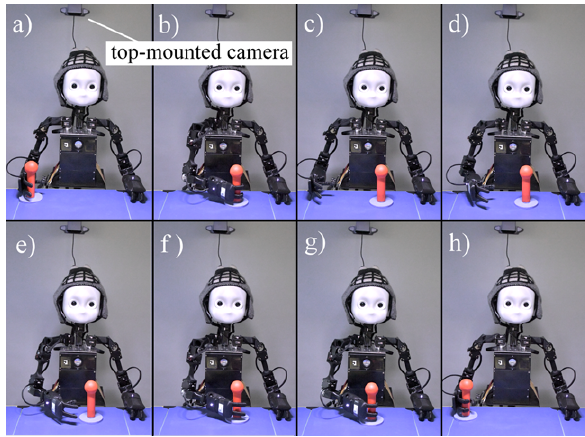
Figure 9: NICO experimental setup during learning including a red object for grasp-learning and a top-mounted camera. The exper- iment starts with NICO’s hand at its start position (a). Using its shoulder joint, NICO grasps and moves the object to a random tar- get position which is then recorded (b). Next, NICO moves back the hand to the home position (c). Learning starts by taking the image provided by the top-mounted camera as an input and producing an action output from the actor network of the Deep RL algorithm. A se- quence of actions is mostly required to reach and grasp the object since the maximum angle change of the joint is limited (d-f). NICO closes its hand when the algorithm recognizes that the object has been reached (g). Once the object is grasped, the hand with the ob- ject grasped is moved to the home position and the learning cycle is repeated (h). In case of reaching a maximum of 50 action steps, the shoulder joint position is set to the recorded target position to grasp the object and move it to the home position before repeating the learning cycle.